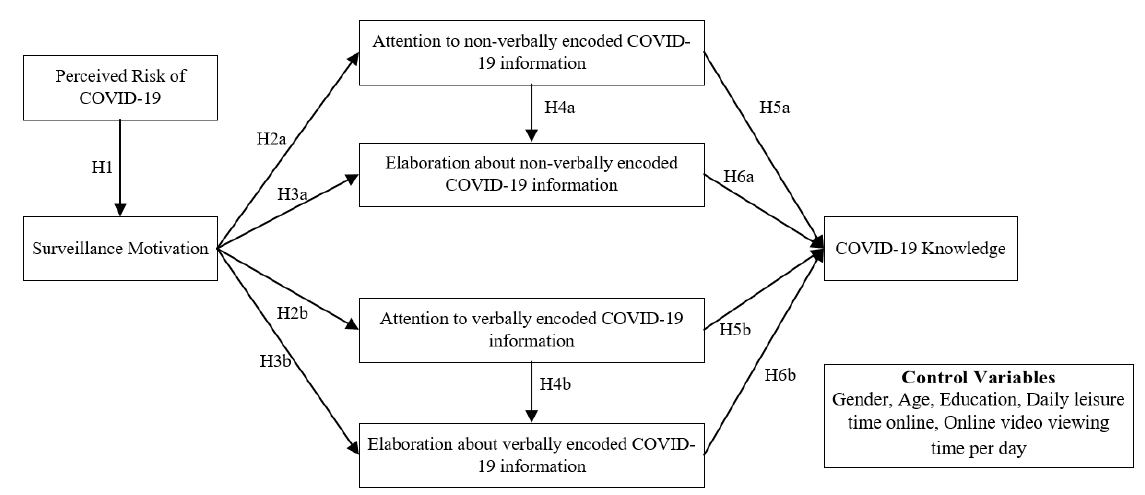
Figure 2. Knowledge learning path model of COVID-19 video